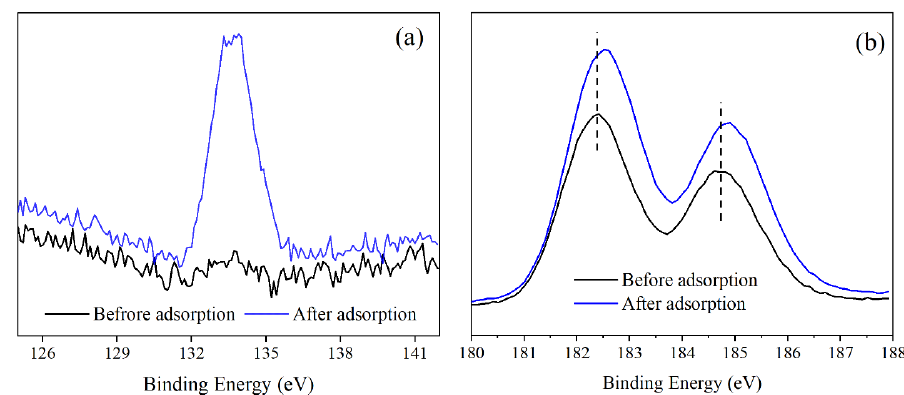
Figure 8. XPS P 2p ( a ) and Zr3d ( b ) spectra of MZ before and after adsorption.